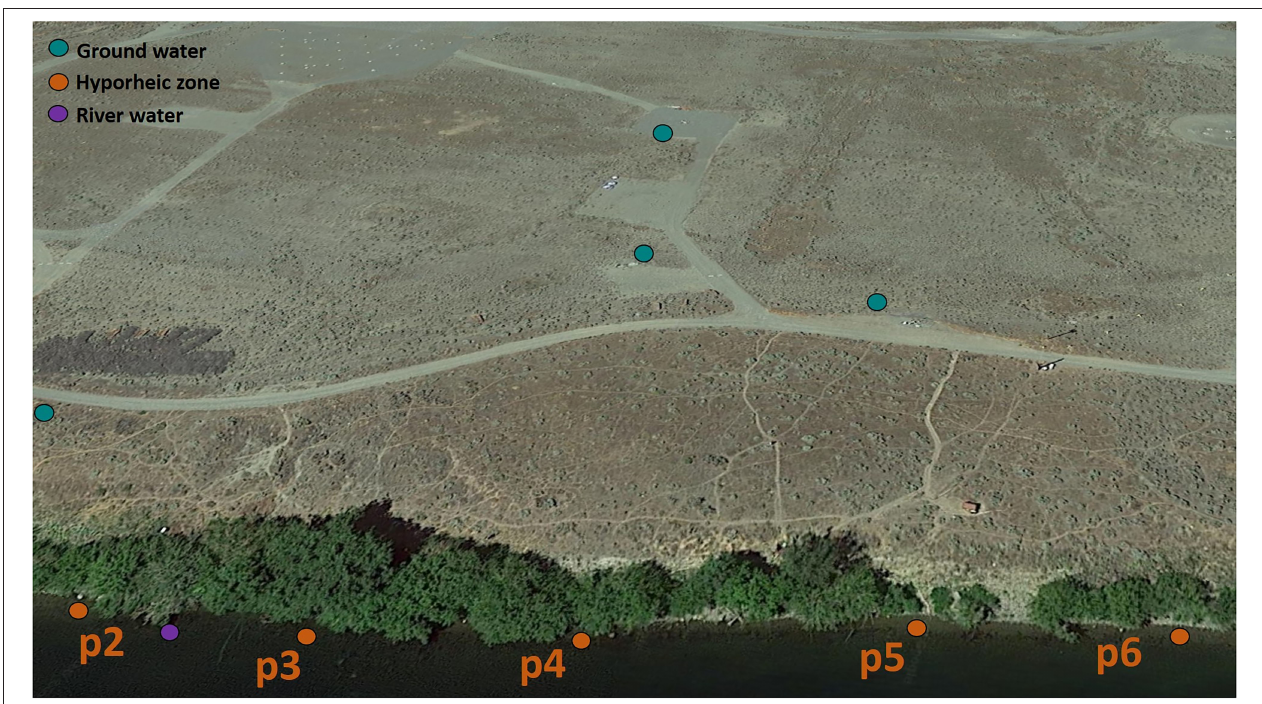
FIGURE 1 | Sampling schematic within the Hanford field sampling site (Google Earth, earth.google.com/web/) of the Ground water, River water, and Hyporheic zone. Piezometer 6 was sampled within the depth intervals of ∼ 1–11 and ∼ 41–51cm whereas piezometers 2–5 were sampled within the depth intervals of ∼ 10–20 and